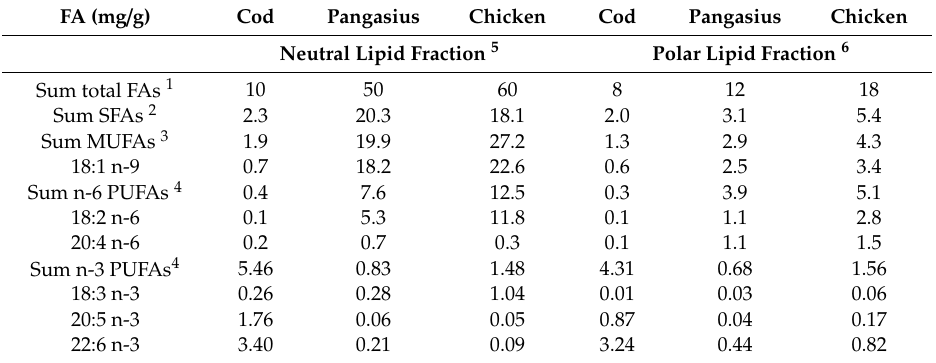
Table 1. Fatty acid composition in the neutral and polar lipid fractions from freeze-dried protein sources used in the experimental diets.